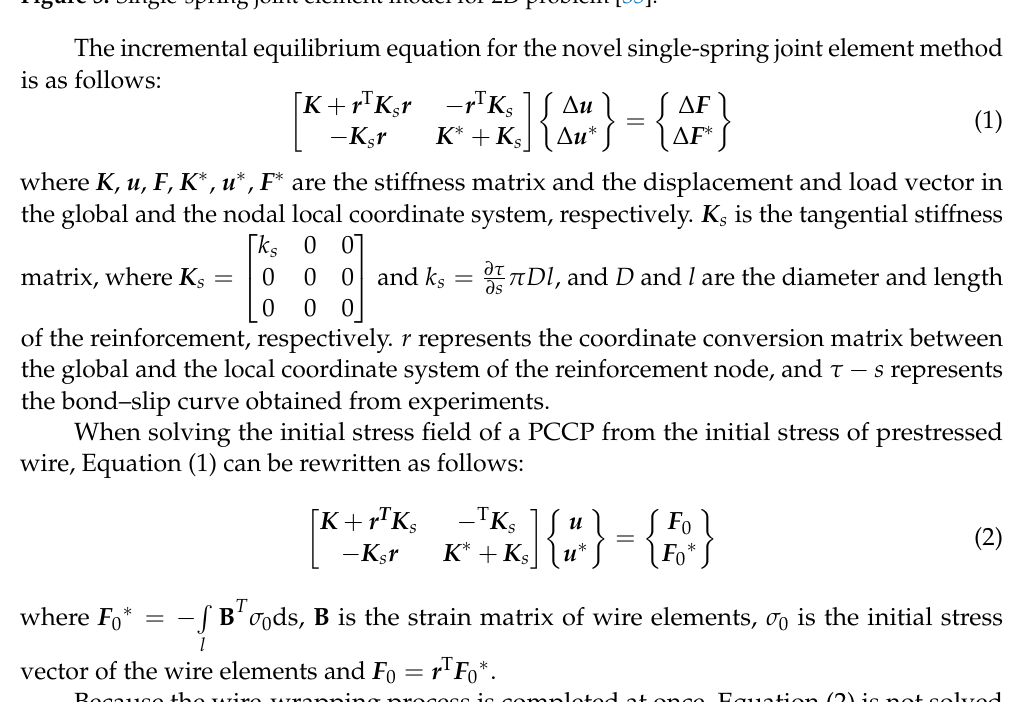
Figure 5. Single-spring joint element model for 2D problem